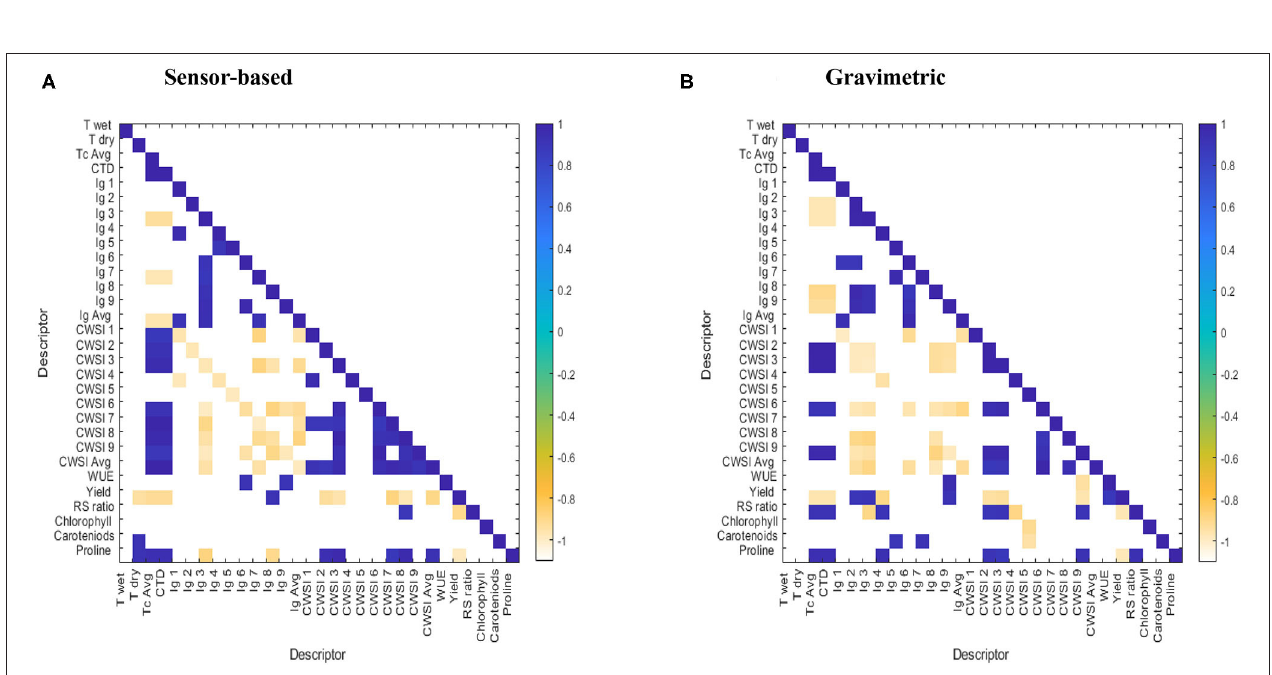
FIGURE 5 | (A,B) Correlation matrix for the studied parameters including water use efficiency (WUE), root: shoot (RS) ratio, yield, average canopy temperature (Tc Avg), maximum temperature (Tdry), minimum temperature (Twet), canopy temperature depression (CTD), average crop water stress index (CWSI Avg), proline, total chlorophylls (Chlorophyll) and carotenoids content derived from (A) - sensor-based and (B) - gravimetric irrigation methods. Numbered parameters including Ig 1–Ig 9 as well as CWSI 1 -CWSI 9 refer to the Ig and CWSI values obtained from corresponding nine subsections in each growing container. Tc Avg, CWSI Avg, and Ig Avg represent the average of nine Tc, CWSI and Ig values, respectively. Treatments included five irrigation levels including 7.5, 17.5, 25, 30, and 35% EVC.